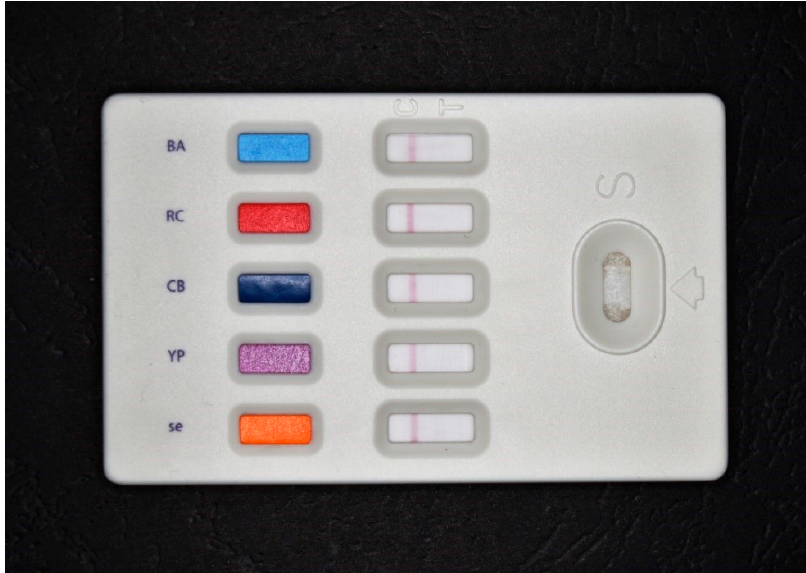
Figure 1. Example of a colorimetric, commercially available, biosensor on the principle of lateral flow assay for the determination of Bacillus anthracis (indicated by letters BA on the biosensor), ricin (indicated by letters “RC”), botulinum toxin (indicated by letters “CB”), Yersinia pestis (indicated by letters “YP”) , staphylococcal enterotoxin B (indicated by letters